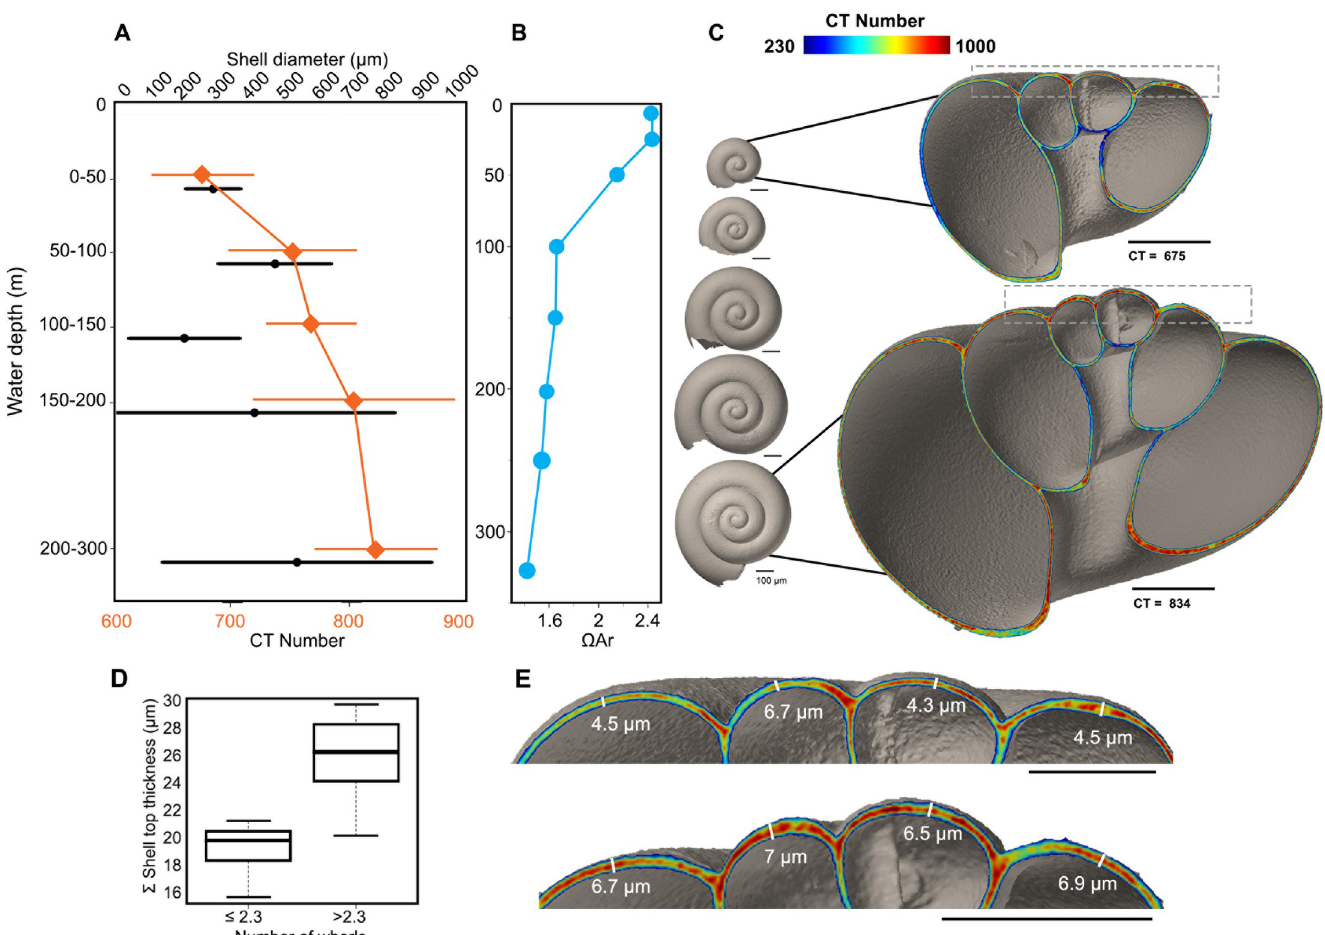
Fig 8. Limacina helicina from water column. A) Limacina helicina shell diameter (n = 175) and density (n = 25) (given by CT number) with depth. B) Aragonite saturation at sampling site plotted against water depth. C) Generalized shell size with depth (left) and cross-sections of L . helicina specimens from 0–50 m (2 whorls), and 150–200 m (2.75 whorls) water depth interval. Grey boxes are shown as close-ups in E. D) Boxplot of Mann-Whitney U test on top shell thickness of L . helicina as a function of whorl number. E) Top of L . helicina specimens shown in C, schematic of shell thickness measurements performed on all shells. Scale bars measure 100 μ